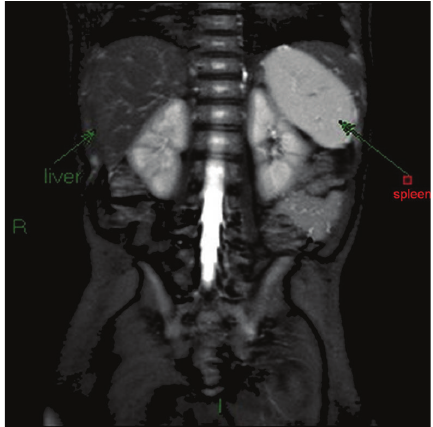
Figure 2: Follow-up abdominal MRI, coronal view, at 8 months showing normal intensity of liver parenchyma on T2WI with fat saturation